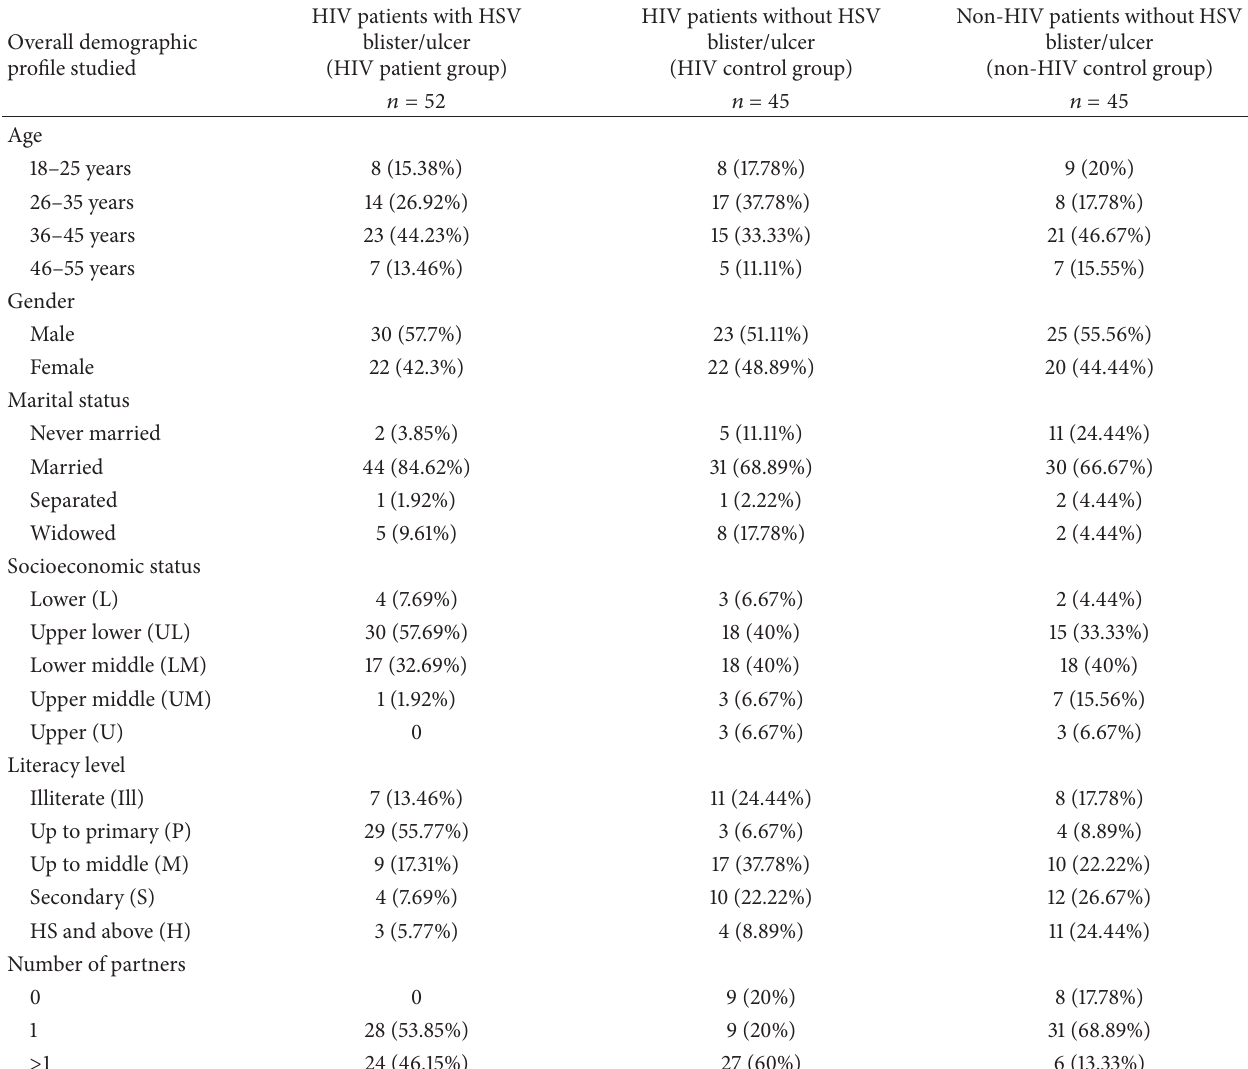
Table 1: Distribution of study population according to various